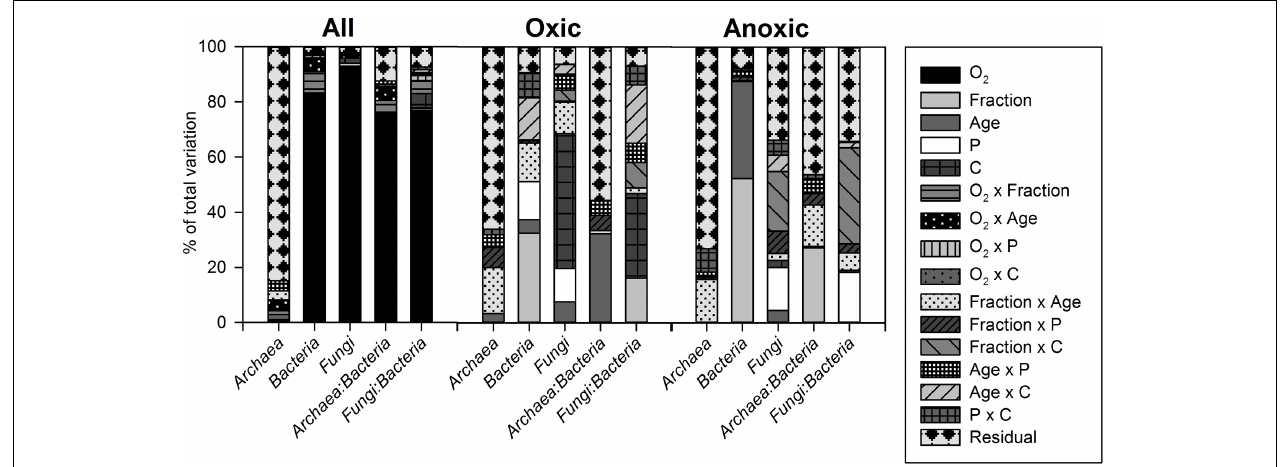
FIGURE 5 | Variance component estimation of factors (O 2 , fraction, soil age, P, and C addition and their two-way interactions) controlling microbial abundances and abundance ratios in the whole data set (all), and the oxic and anoxic subsets (without the LF, controls, and inoculum) for the soil microcosm incubation experiment.